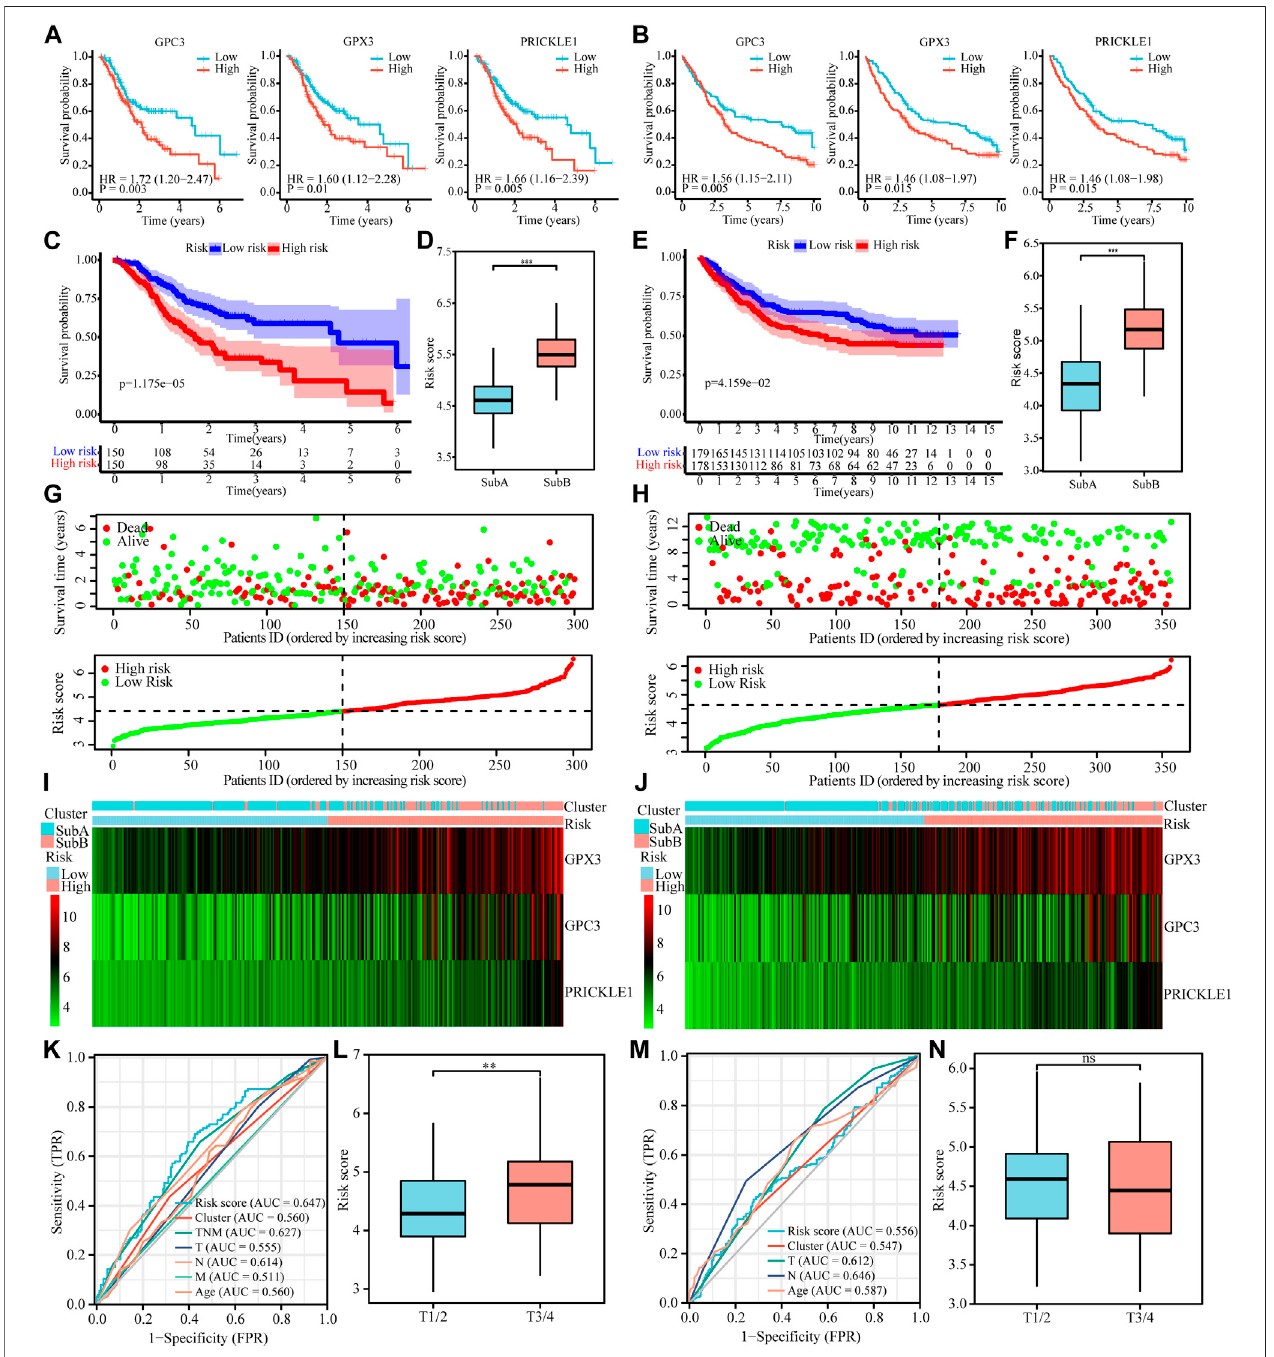
FIGURE5| Coxproportionalhazardsmodelwasusedtoidentifytheprognosticsignature.(AandB)Kaplan-MeiercurveplotforkeyprognosticgenesofTCGA (A) and GEO (B) cohorts. (Cand E) Kaplan-Meier curve plot forkeyprognostic genes-basedriskmodel ofTCGA (C) and GEO (E) cohorts. (Dand F) Risk score ofthetwo subtypesinTCGA (D) andGEO (F) cohorts. (GandH) DistributionandcurrentstatusofgastriccancerriskscoresinTCGAandGEOcohorts,whichindicatedthathigh- risk score was related to poor prognosis. (I and G) Heatmaps showed that the degree of key prognostic genes expression in different risk score and the two subtypes in TCGA (I) and GEO (G) cohorts. (K and M) ROC of risk score prediction model on TCGA (K) and GEO (M) cohorts. (L and N) Survival curves of gastric cancer patients with combinations of risk score and T stage in the TCGA (L) and GEO (N) cohorts.